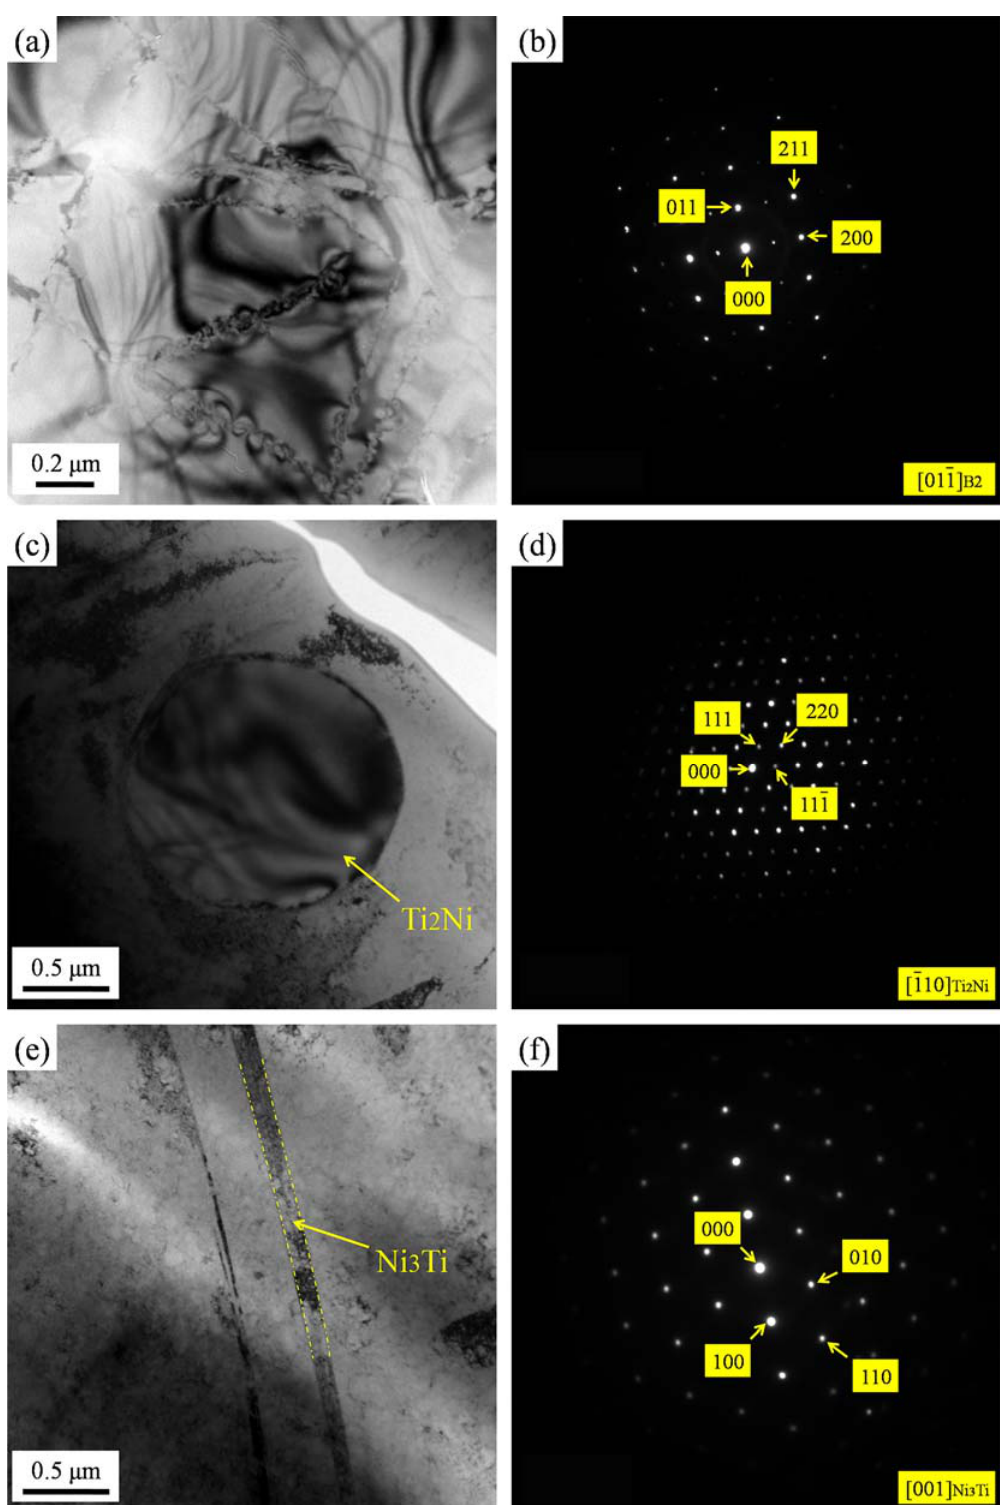
Figure 5. TEM micrographs of Ni 44 Ti 51.8 Fe 3.2 Ta 1 SMA: ( a ) Bright field image showing B2 austenite matrix; ( b ) Diffraction pattern of B2 austenite matrix in ( a ); ( c ) Bright field image showing Ti 2 Ni precipitate; ( d ) Diffraction pattern of Ti 2 Ni precipitate in ( c ); ( e ) Bright field image showing Ni 3 Ti precipitate; ( f ) Diffraction pattern of Ni 3 Ti precipitate in ( e ).